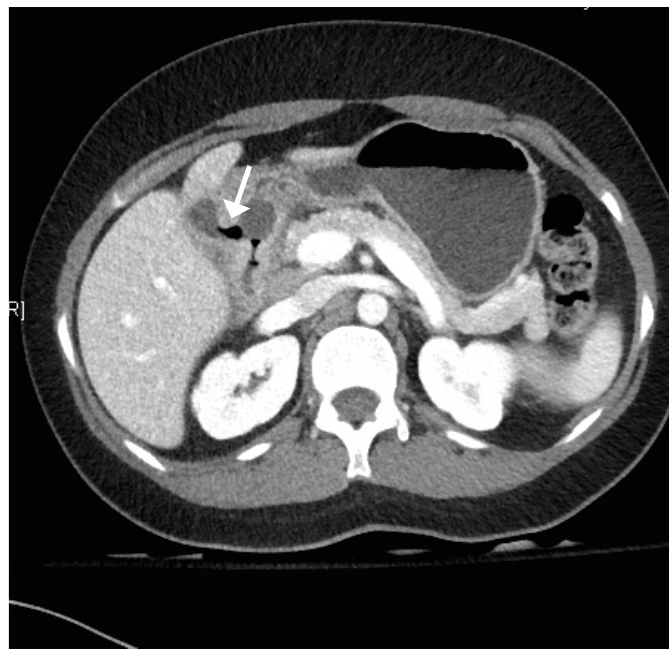
Figure. Transverse computed tomography of air passing from duodenum through a fistula into the